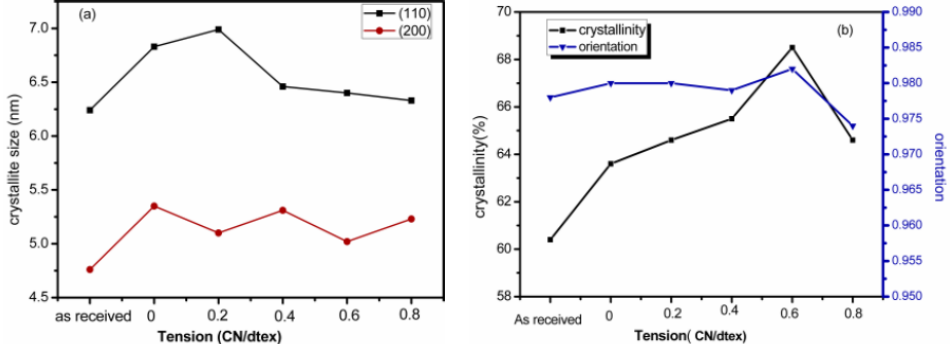
Figure 8. Crystallite sizes ( a ); crystallinity and crystal orientation ( b ) of Kevlar 49 fibers treatment in scCO 2 under various tensions.